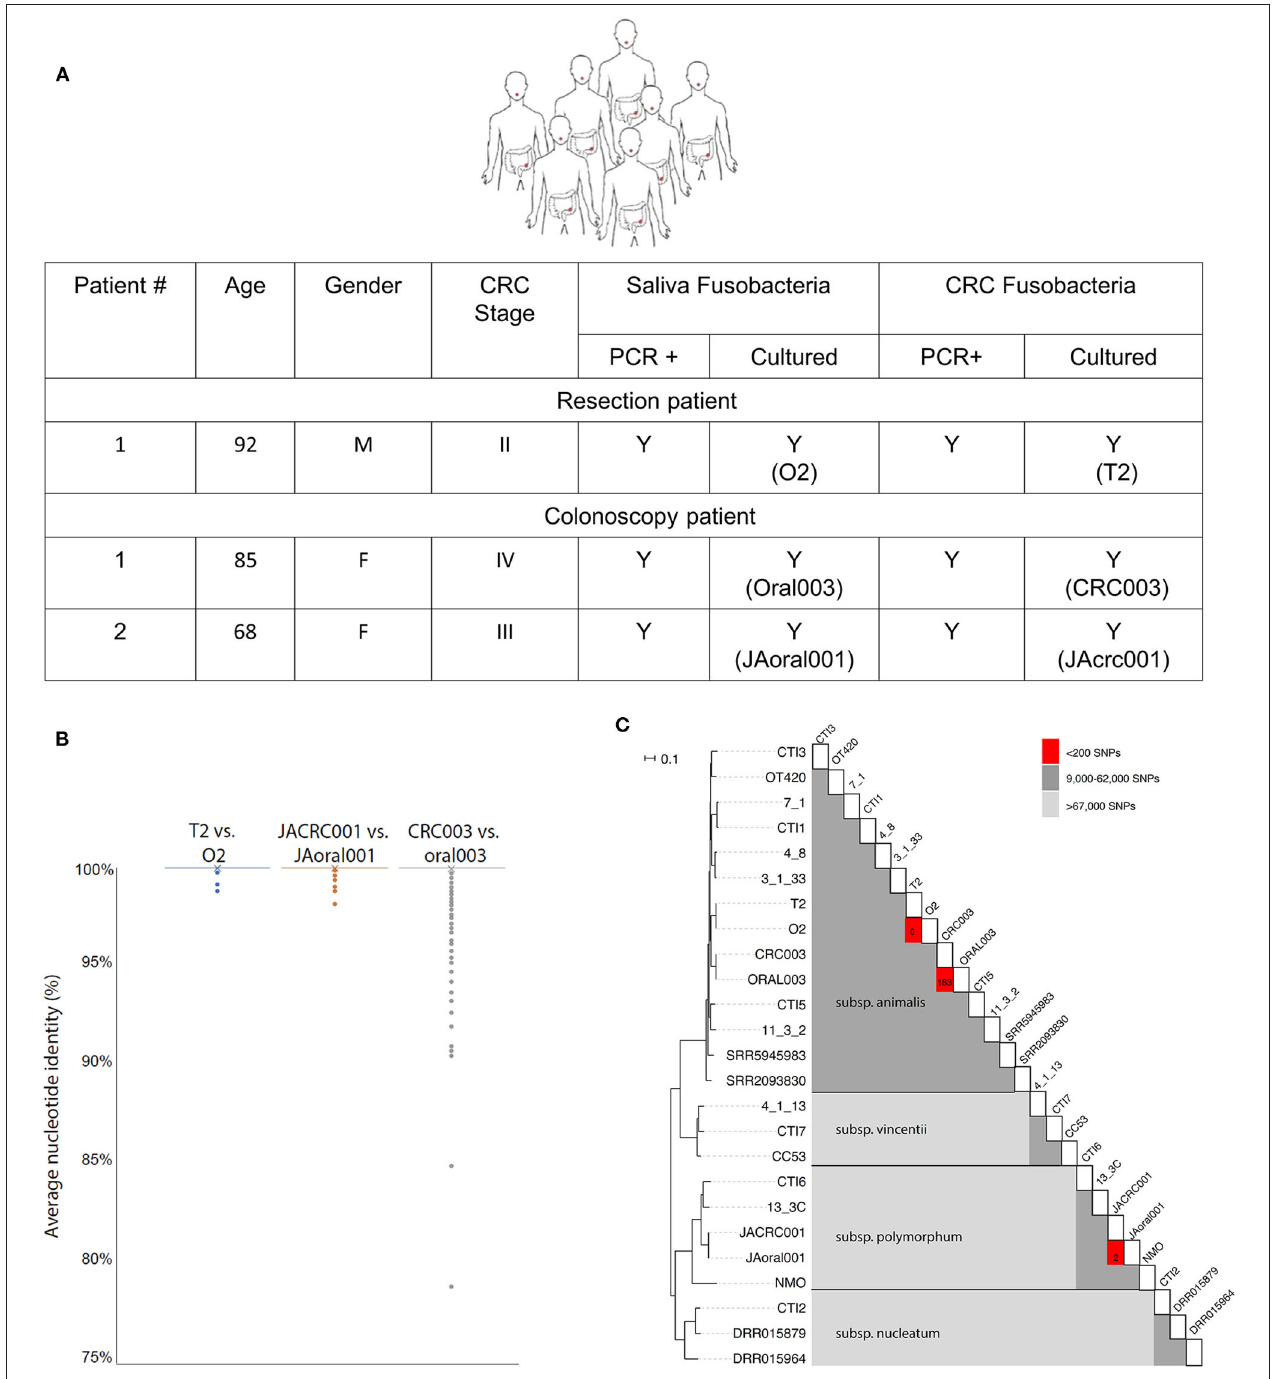
FIGURE 1 | CRC fusobacteria are of oral origin. (A) Metadata, saliva, and CRC fusobacteria PCR and culture status of CRC patients. (B) The distribution of whole-genome ANI values for each 1,000 bp genomic window for each pairwise comparison of strains. Almost all windows resulted in 100.0% identity, with only a few outliers depicted here (see section Methods). Average ANI values were 100.00 ± 0.03% (T2 vs. O2), 100.00 ± 0.04% (JAoral001 vs. JACRC001), and 99.98 ± 0.38% (CRC003 vs. oral003). (C) Midpoint-rooted, SNP-based phylogeny of F. nucleatum strains reveals that T2 and O2 are highly related. A heat map illustrating the SNP matrix is shown. For the closely-related strains, the count of SNPs differing is shown in the red boxes. T2 and O2 differ by zero SNPs, and CRC003/ORAL003 differ by 183 SNPs and JAcrc001/JAoral001 differ by 2 SNPs.